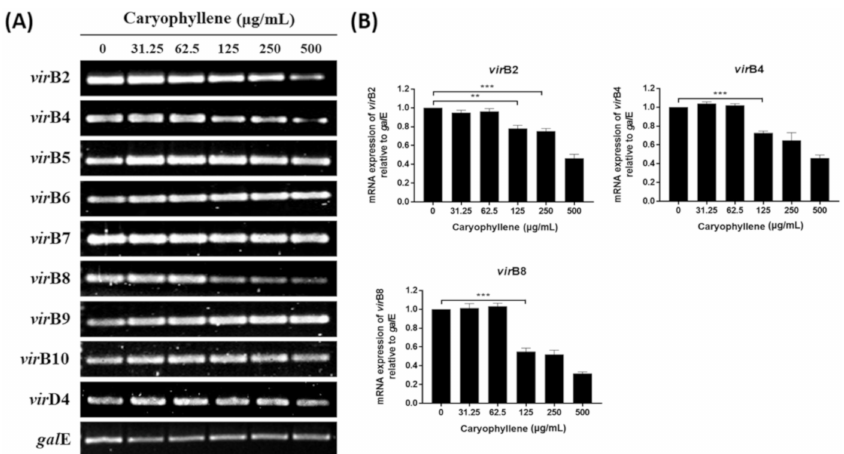
Figure 6. Inhibitory e ff ect of β -caryophyllene on the CagA translocation through T4SS. ( A ) H. pylori was treated with indicated concentrations of β -caryophyllene and the RNA was extracted. The collected RNA was subjected to reverse transcriptase-polymerase chain reaction (RT-PCR) to detect the expression of T4SS components. The gal E was used as an internal control. ( B ) The density of the bands were illustrated as a graph, and the results from triplicate experiments were analyzed by Student’s t -test (** p < 0.01 and *** p <